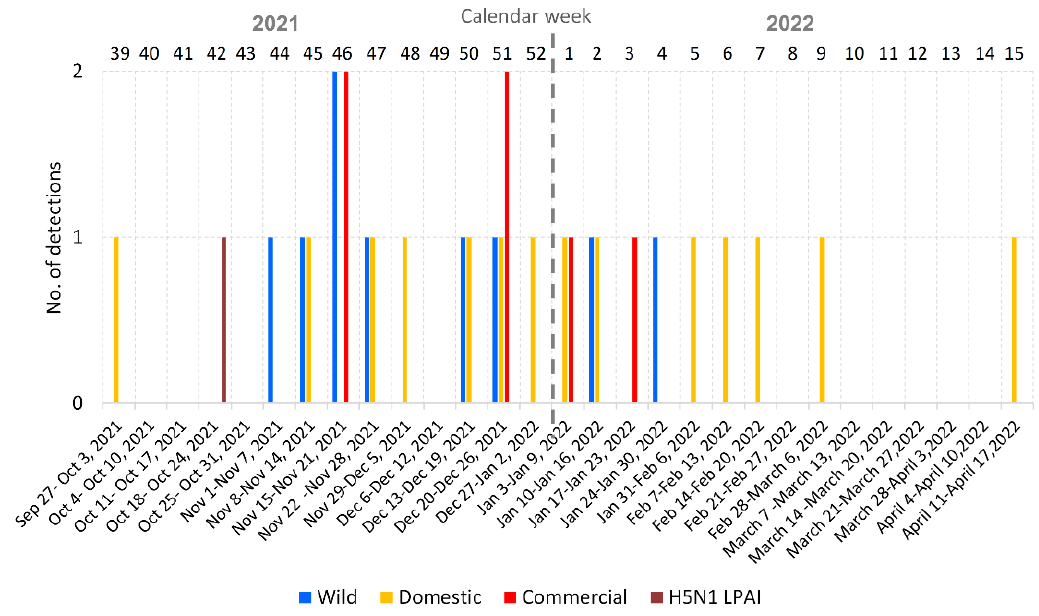
Figure 1. Distribution of AIV detections in the 2021/2022 season in the Czech Republic. Bar chart showing the number of HPAI/LPAI outbreaks detected per calendar week.